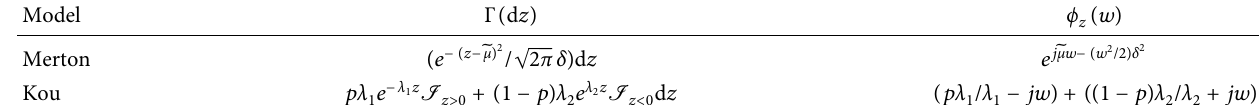
Table 2: Jump model